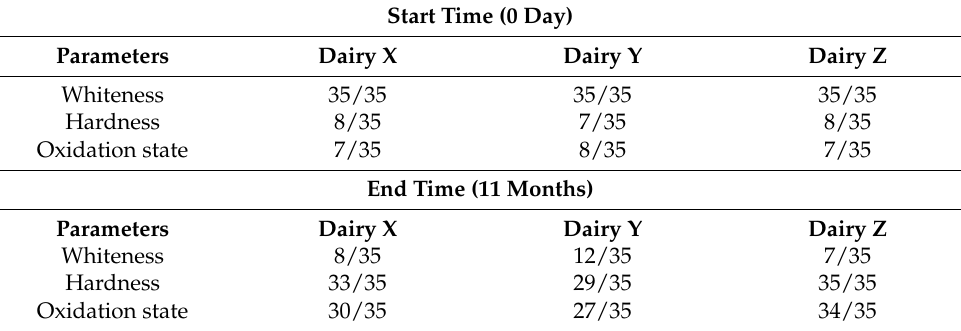
Figure 4. SDS PAGE of the matrices of the three dairies: ( a ) Dairy X; ( b ) Dairy Y; ( c ) Dairy Z. The results reported are referred to the beginning of the experiment (T0; fresh matrices, 0 day) and to the end of the freezing storage (T11; 11 months). The fragment γ 4-casein selected for this study has been indicated as “ β -CN (69-209)”. The matrices were: RM (raw milk), TM (thermized milk), PC (pre-mature curd), MC (mature curd) and BMC (Buffalo Mozzarella cheese). STD (Standard) is the Protein Molecular Weight Marker (10-250 kDa). Table 3. Densitometric analysis of the matrices of the three dairies: (a) Dairy X; (b) Dairy Y; (c) Dairy Z. The results reported are referred to the beginning of the experiment (T0; 0 day) and to the end of the freezing storage (T11; 11 months). Values are expressed as % of the amount of γ 4-casein Table 4. “Single Scores” of BMC from each dairy at the beginning (0 day) and at the end of the experiment (330